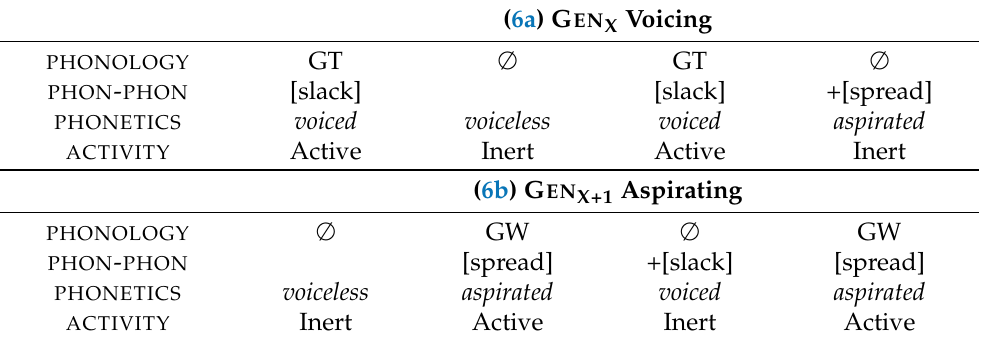
Table 7. Comparison of cross-generational laryngeal